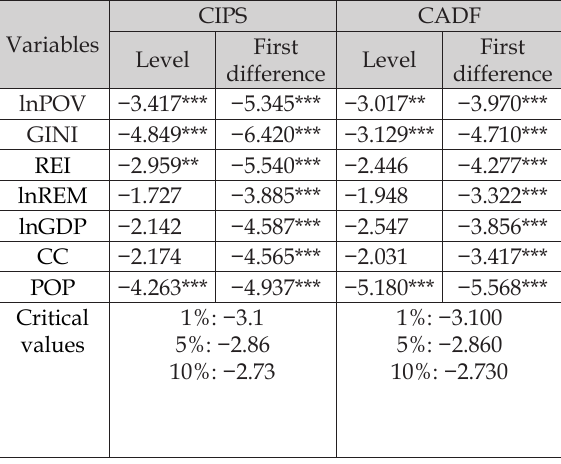
Table 6. Panel unit root test results.